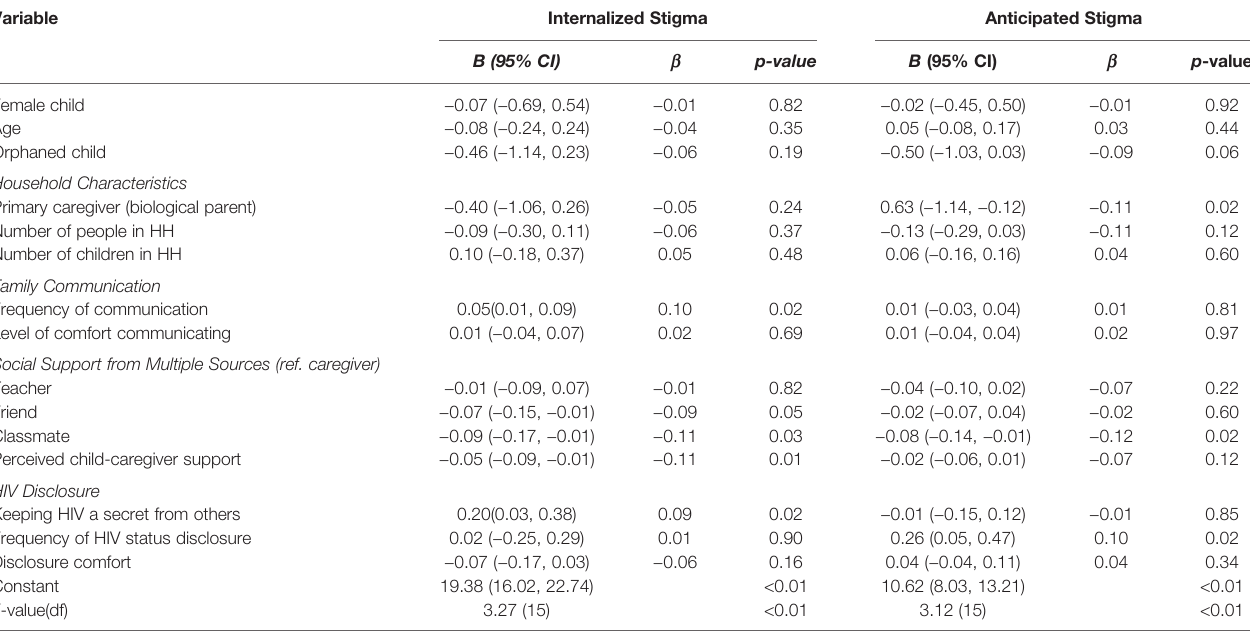
TABLE 4 | Family Communication and Social Support Factors Associated with HIV Internalized and Anticipated Stigma (N = 702).